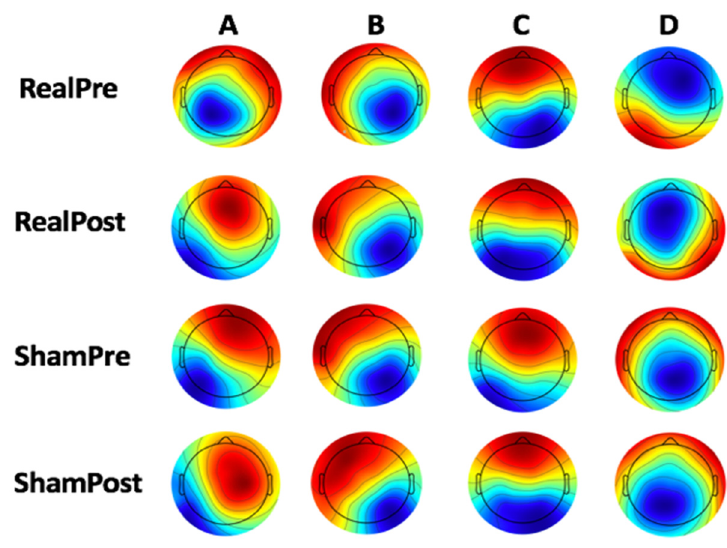
Figure 2. Microstates ( A – D ) template for each condition .